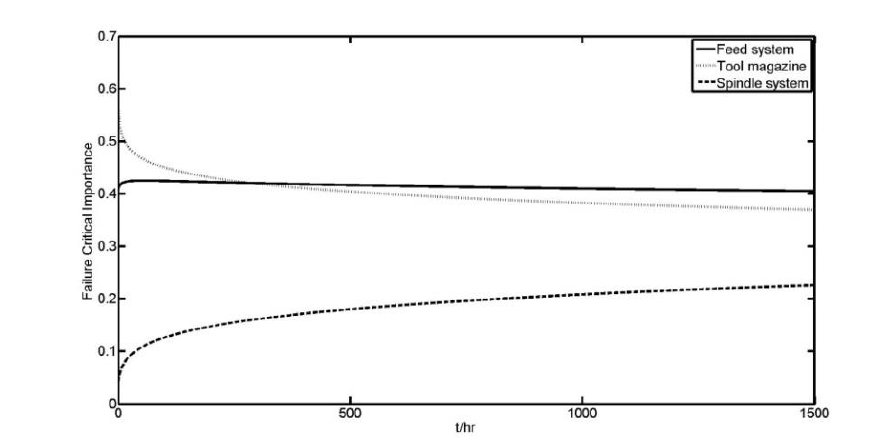
Figure 6. Comparison of key components Failure criticality